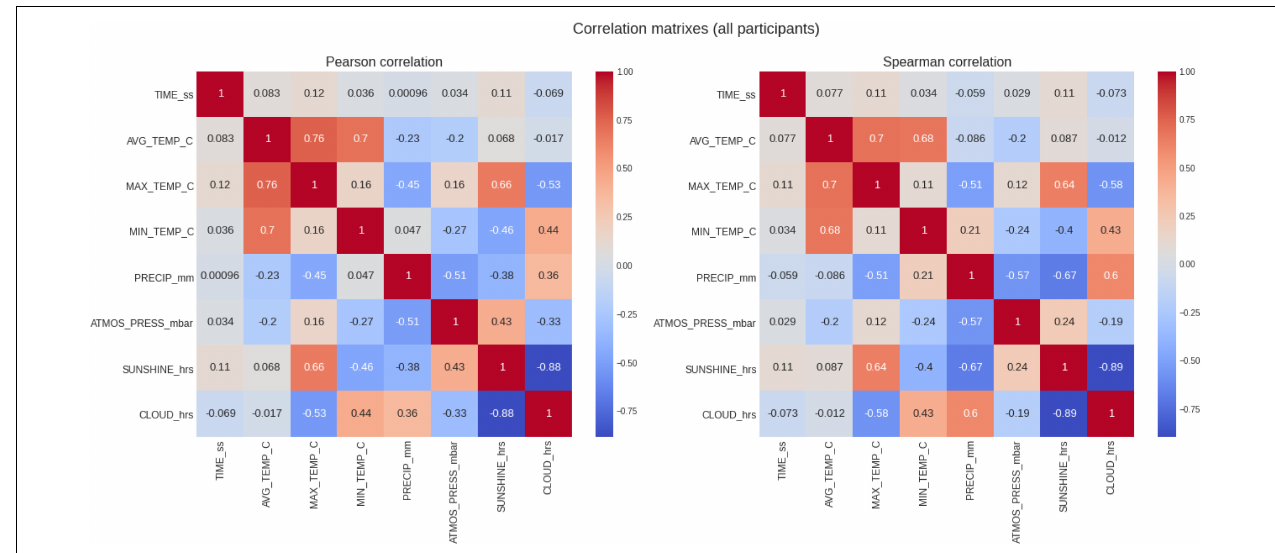
FIGURE 3 | Analysis of the correlation of the target variable (marathon race time) and the descriptive variables (weather conditions) for all runners. PRECIP, precipitation in mm, SUNSHINE duration in hours, CLOUD cover in hours; ATMOS_PRESS, atmospheric pressure in mbar; AVG_TEMP, average temperature in degrees Celsius; MAX_TEMP, maximum temperature in degrees Celsius; MN_TEMP, minimum temperature in degrees Celsius.